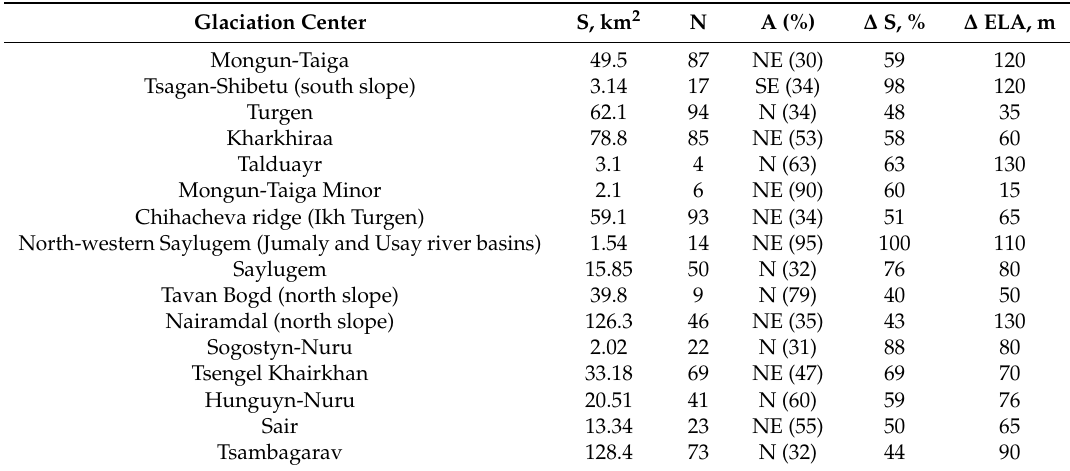
Table 9. Reconstructed LIA glazierisation of different glacial centers and their changes till present (2002–2013) [27]. Glaciation Center S, km 2 N A (%) ∆ S, % ∆ ELA,